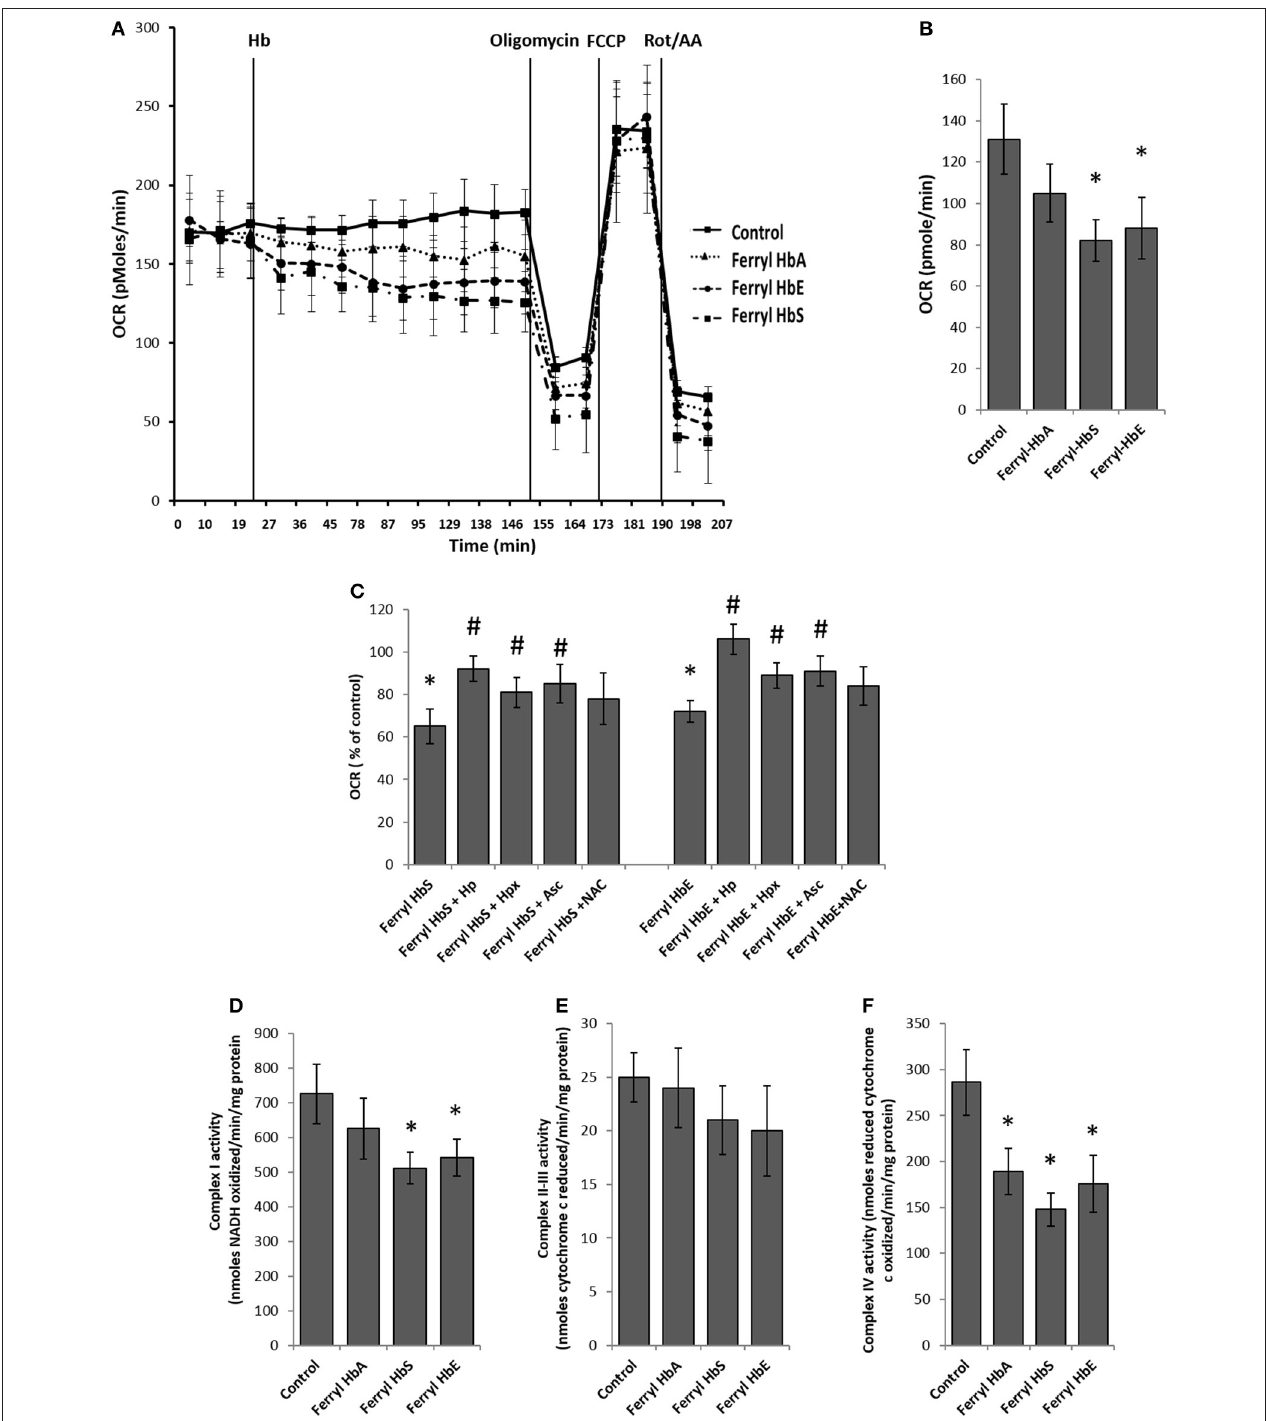
FIGURE 5 | Oxidized ferryl hemoglobins disrupt pulmonary endothelial bioenergetics. (A) HPAEC were grown on 24 well XF-plates. Mitochondrial oxygen consumption rates (OCR) were measured for 2h using XF24 extracellular flux analyzer with direct infusion of ferryl forms of HbA, HbS, or HbE at equimolar concentration (100 µ M) ( N = 3). (B) Basal OCR following 2h incubation with ferryl Hbs ( N = 3). (C) Average basal OCR values from a similar set of experiments in which HPAEC were exposed to either ferryl HbS (100 µ M) or ferryl HbE (100 µ M) for 2h co-incubated with or without equimolar Hp or Hpx or Asc or NAC ( N = 3). Statistical significance between means was calculated by paired Student’s t -test. * P < 0.05 vs. untreated control, # P < 0.05 vs. respective ferryl Hb. (D) Complex I activity (E) complex II-III and (F) complex IV activities were measured in isolated mitochondrial fractions incubated with different ferryl Hb proteins for 2h at 37 ◦ C ( N = 4). Differences between individual treated groups and respective untreated controls were compared using Mann-Whitney U -test. * P < 0.05 vs. controls.